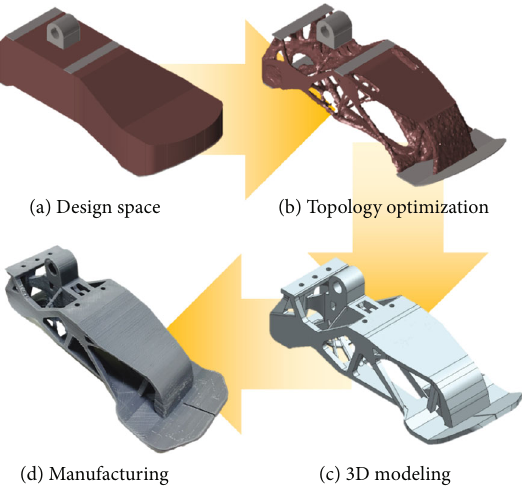
Figure 5: Optimization process for the foot